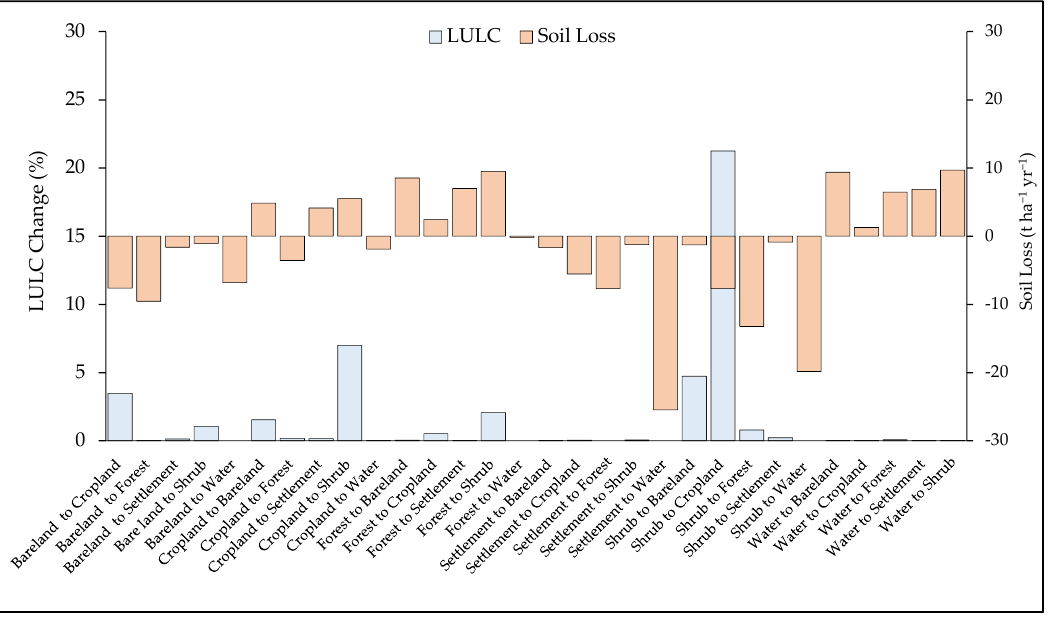
Figure 6. Land Cover Changes and their effects on soil erosion risk in the Erer Sub-Basin, North East Shebelle Basin, Ethiopia. Table 9. Change of erosion risk classes between 2000 and